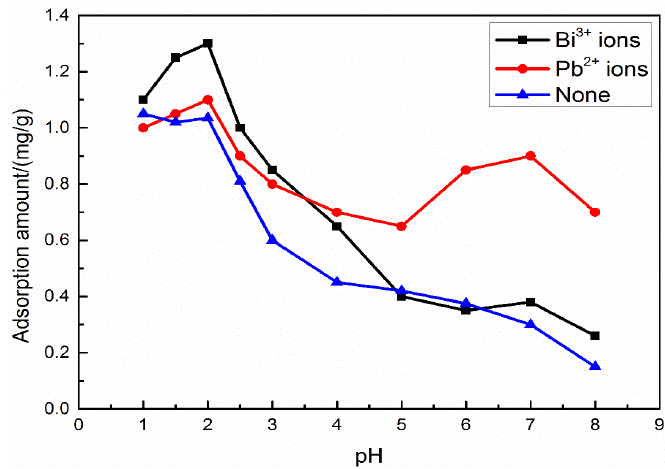
Figure 6. The adsorption amount of SPA on rutile surfaces before and after Bi 3+ ions modification as a function of pH.